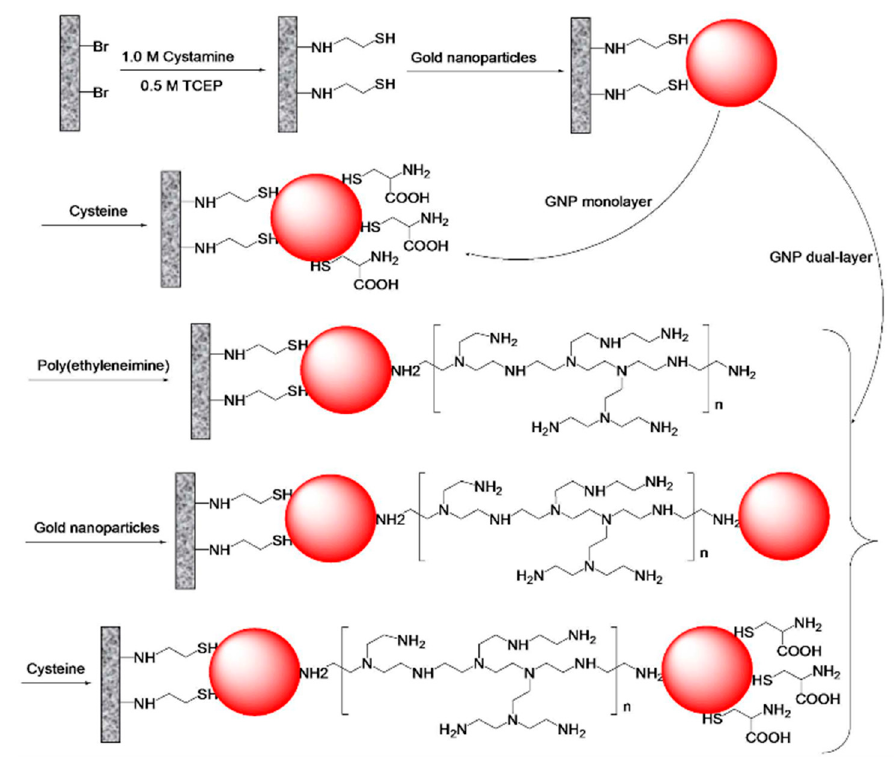
Scheme 5. Scheme of preparation of poly(4-methylstyrene- co -vinylbenzene chloride- co